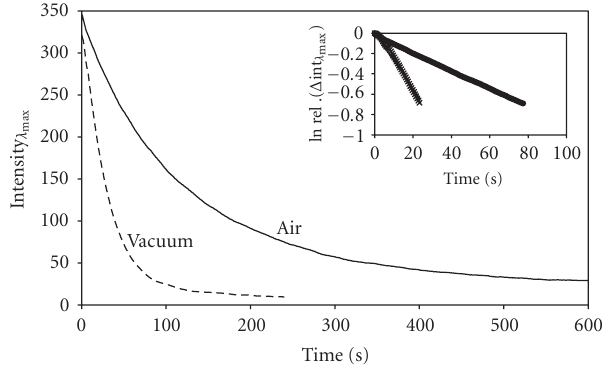
Figure 6: Change in the luminescence intensity, at 470 nm, of a typical, UV-activated ITS oxygen indicator film as a function of time, under an ambient atmosphere (solid line) and when exposed to air (broken line), having been first UV-activated under vacuum. Each film was fully photobleached, using UVA irradiation, before being allowed to recover in air. The insert diagram is a first-order plot, over one half life, derived from the data in the main